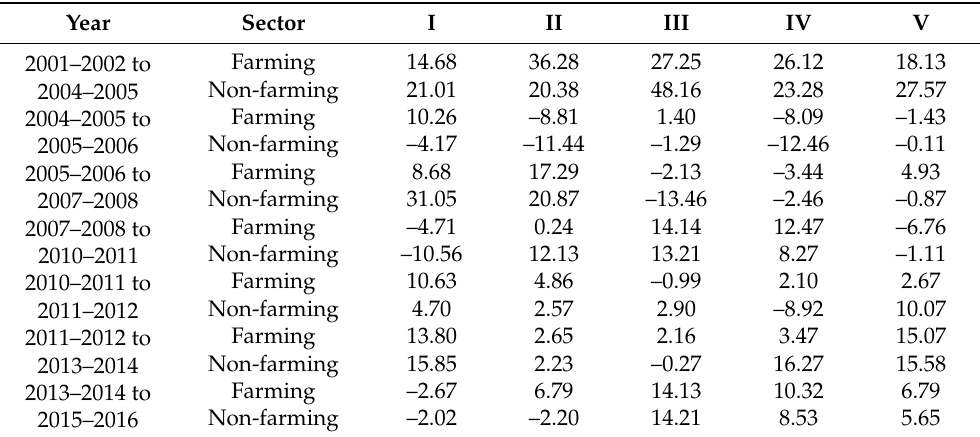
Table 3. Actual growth rate of consumption expenditure across agro-climatic zones in the farming and non-farming